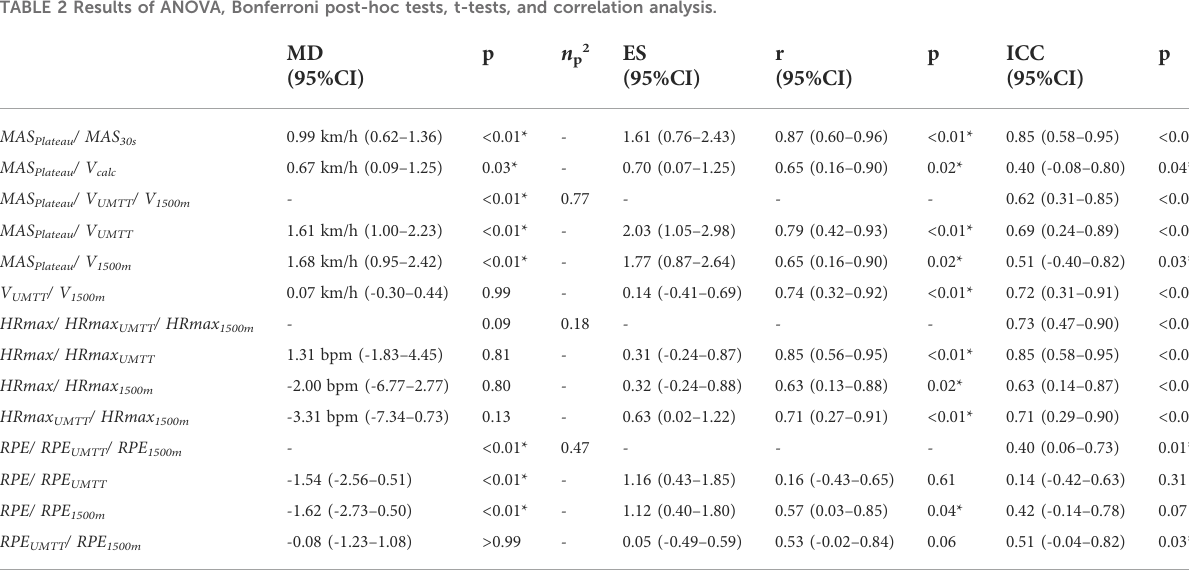
TABLE 2 Results of ANOVA, Bonferroni post-hoc tests, t-tests, and correlation